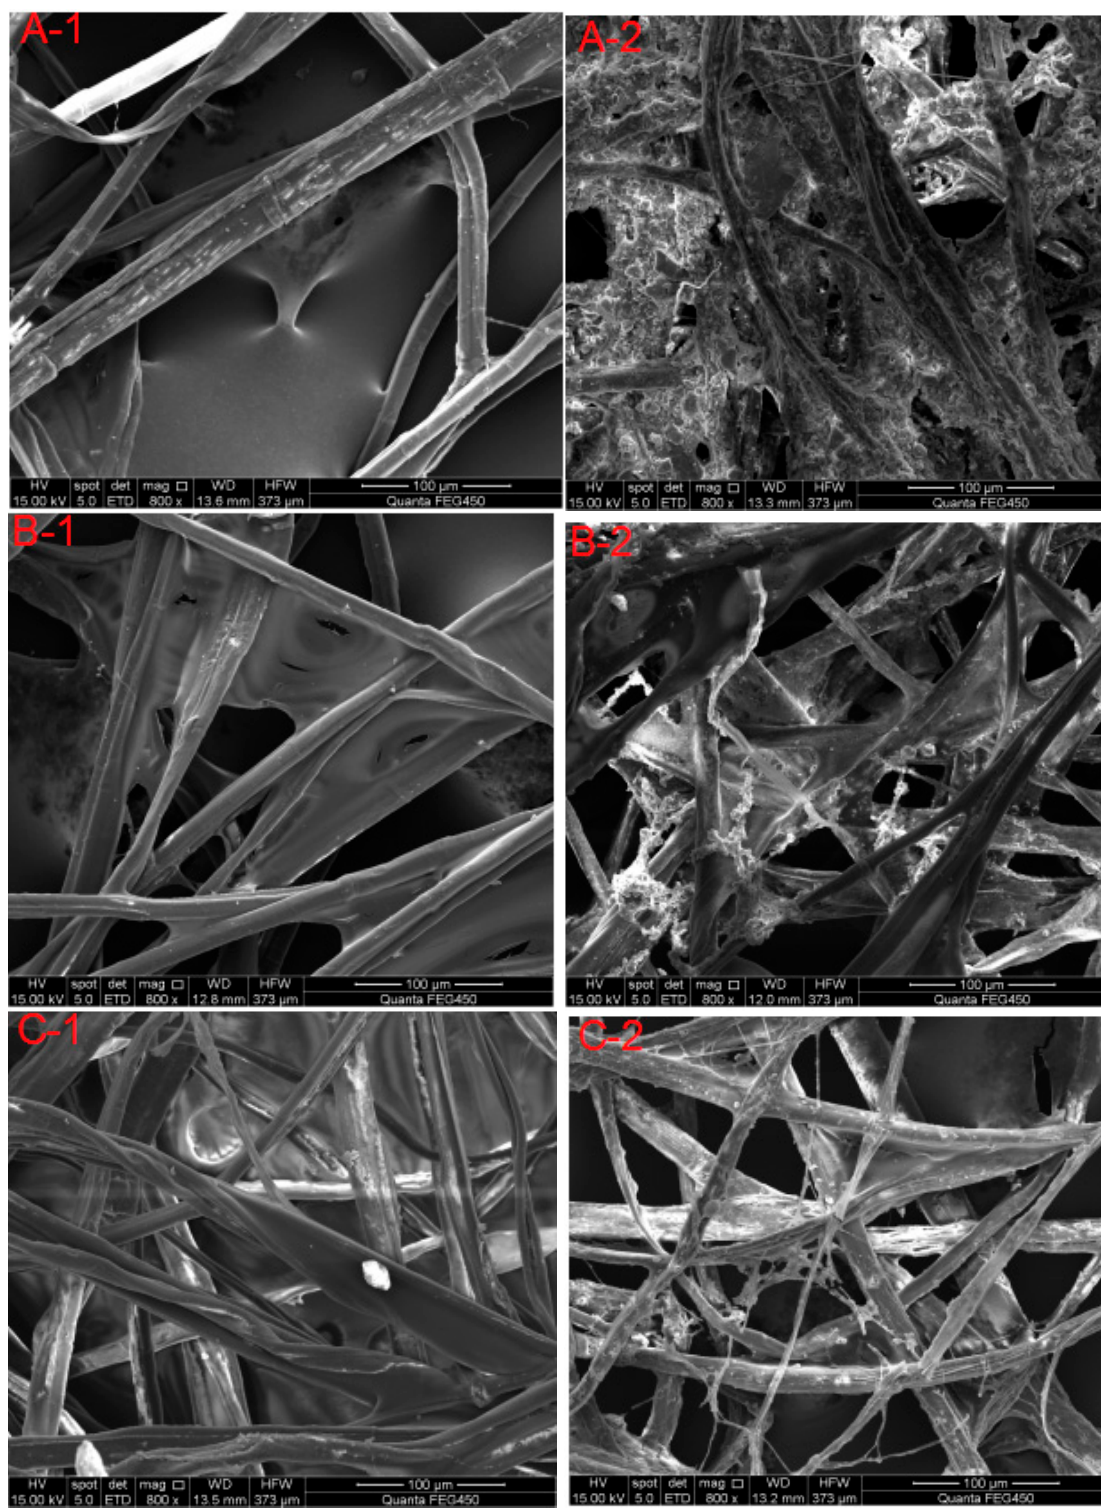
Figure 7. Scanning electron microscopy (SEM) images of film samples before and after degradation. ( A ‐ 1 ) original fiber/starch film; ( A ‐ 2 ) fiber/starch film after 4 weeks of degradation. ( B ‐ 1 ) original fiber/PVA film; ( B ‐ 2 ) fiber/PVA film after 4 weeks of degradation. ( C ‐ 1 ) original fiber/polyacrylate film; ( C ‐ 2 ) fiber/polyacrylate film after 4 weeks of degradation. Both the field and laboratory tests indicate the potential usefulness of the fiber/starch film;